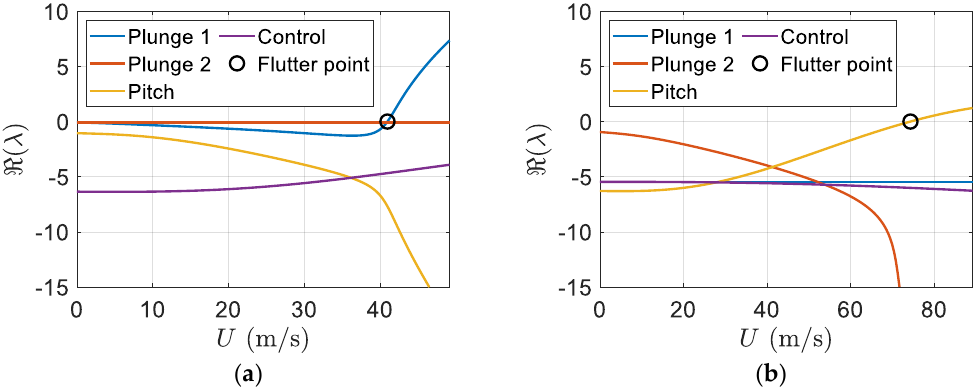
Figure 10. Damping ratio versus airspeed: ( a ) regular blade; ( b ) smart blade. Figure 11 shows the eigenvalues real part versus the velocity of freestream. Again, Figure 11b indicates the flutter speed of the smart blade can be effectively increased in comparison to that of the regular blade one.